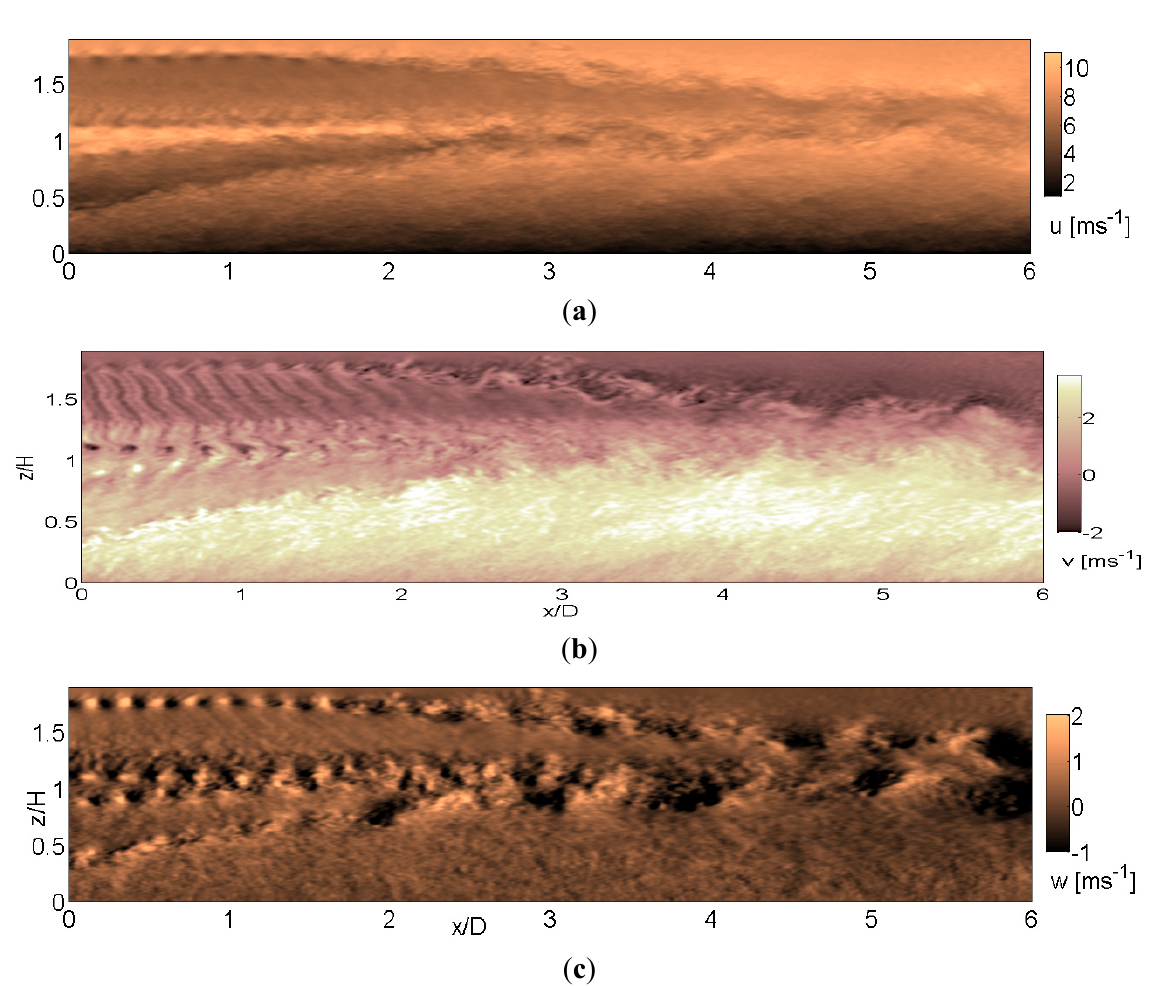
Figure 7. Velocity structure of the ( a ) Streamwise velocity; ( b ) Spanwise velocity; ( c ) wall-normal velocity, at the center plane, y/D = 0 for WT in moderately-stable ABL